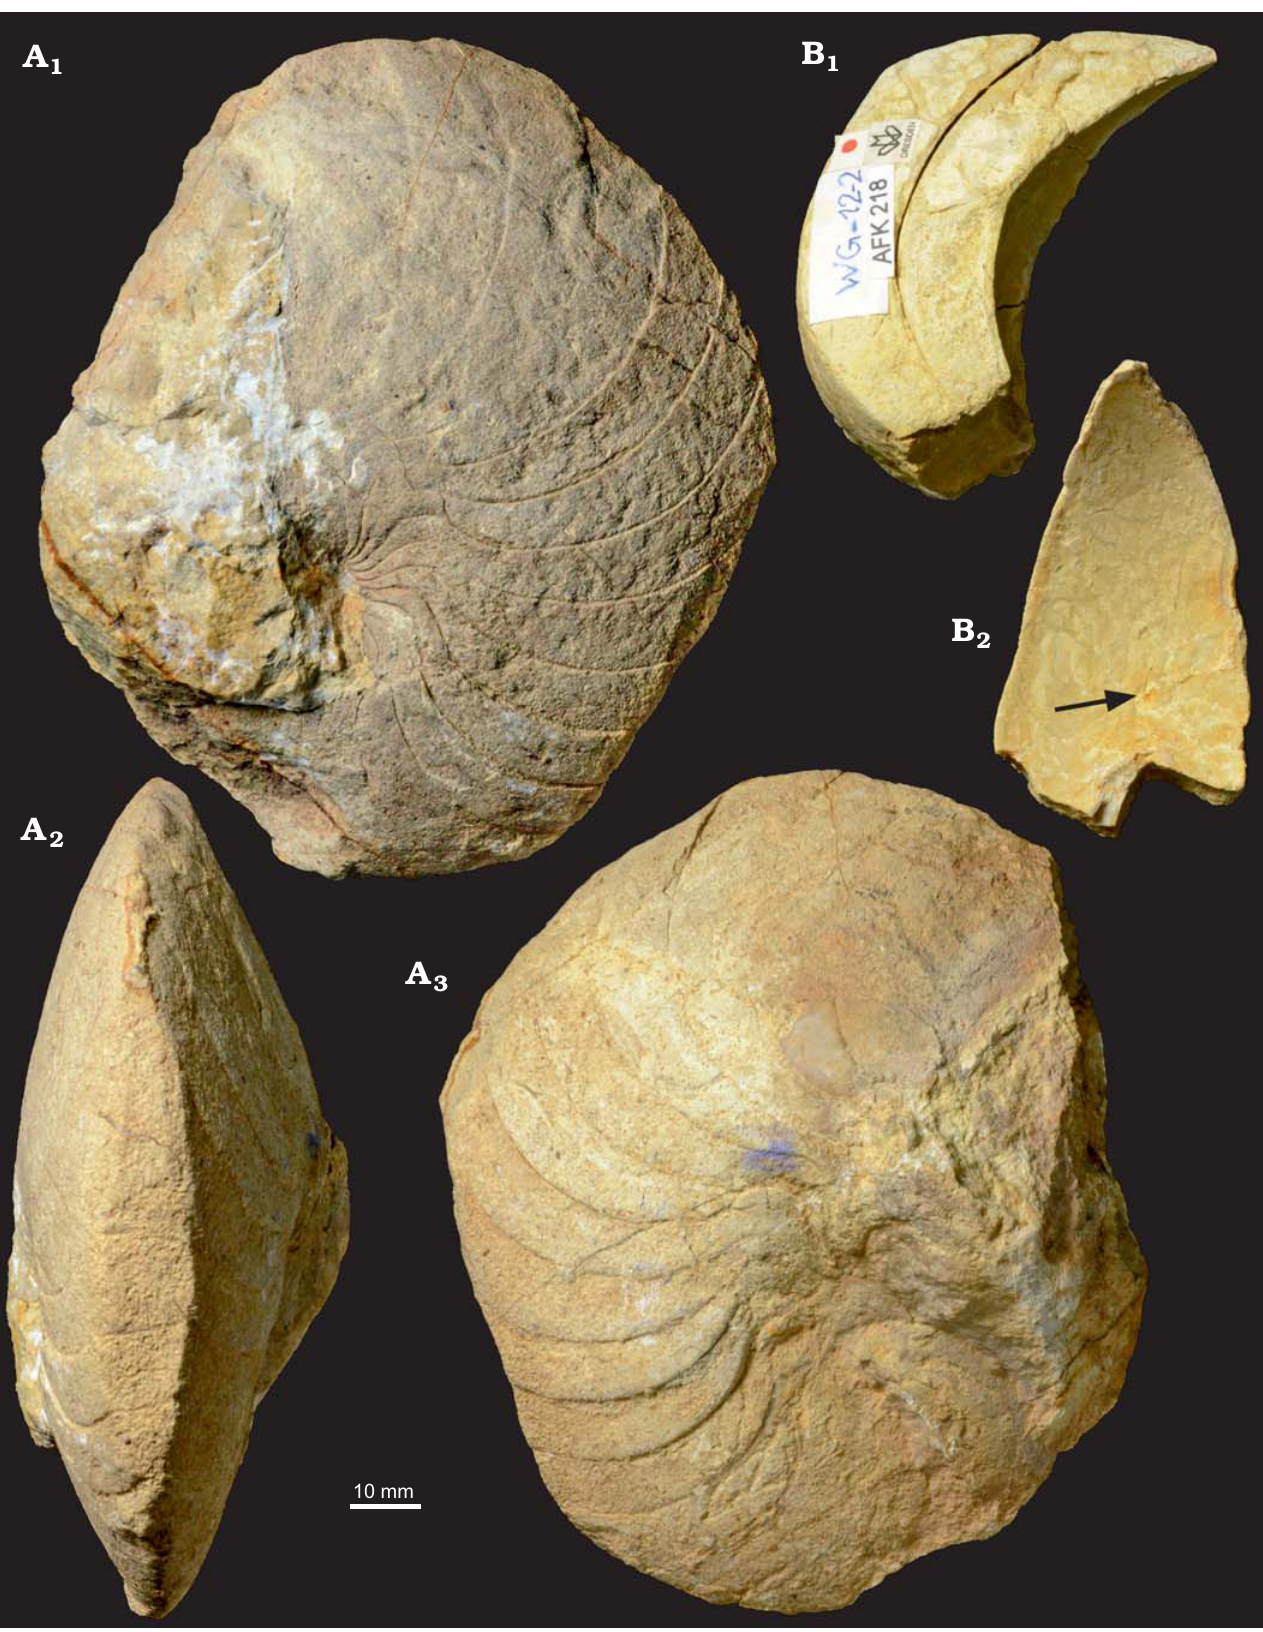
Fig. 4. Hercoglossid nautiloid Angulithes mermeti (Coquand, 1862) from the Cenomanian of Wadi Ghonima, Egypt. A . AFK 202 in lateral (A 1 , A 3 ) and ventral (A 2 ) views. B . AFK 218 in lateral (B 1 ) and apertural (B 2 ) views; arrow shows the position of the